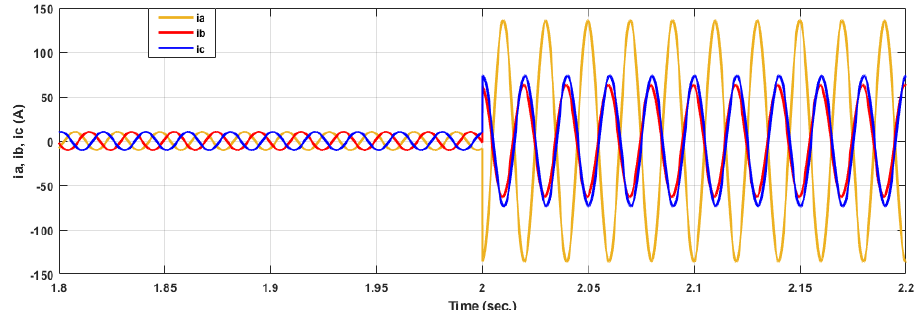
Figure 35. Current signals for 50% short circuit fault in phase a.